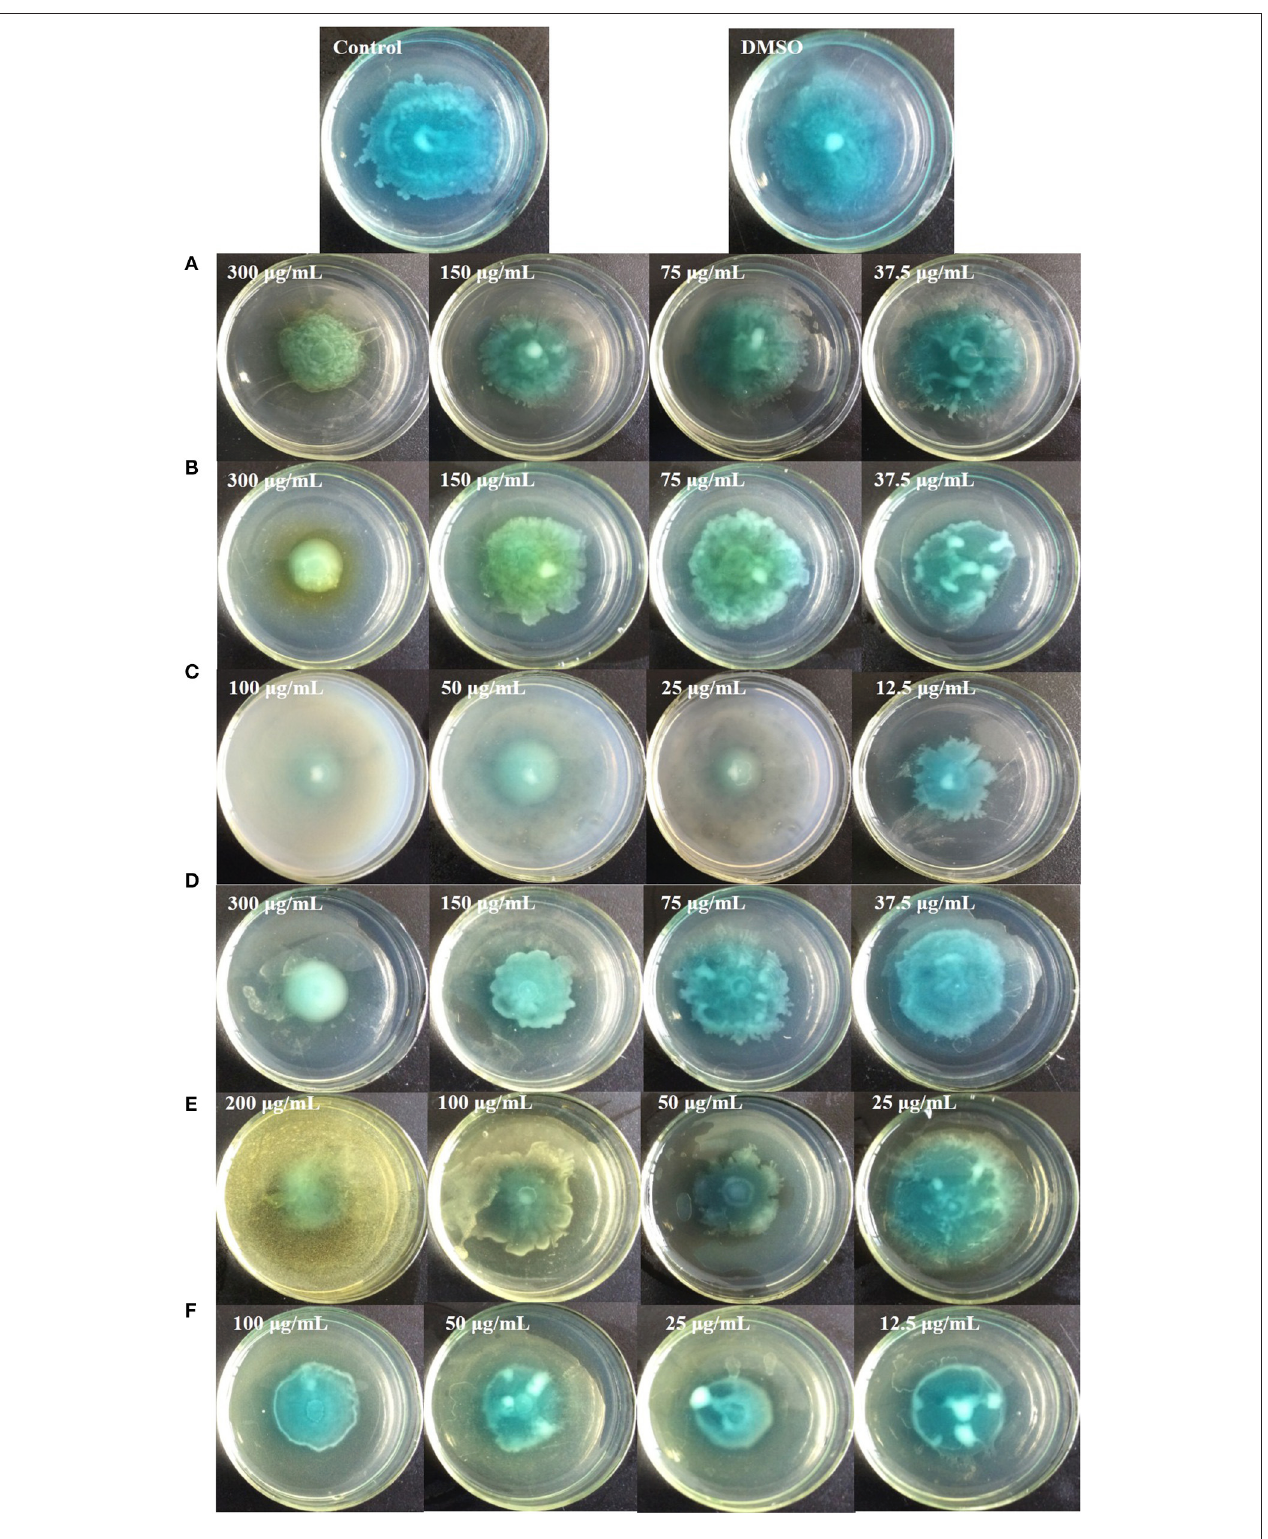
FIGURE 10 | Swimming inhibition assays of the six identified compounds. Gallic acid (A) , Catechin (B) , Ellagic acid (C) , Chlorogenic acid (D) , Quercetin (E) , and Kaempferol (F) .